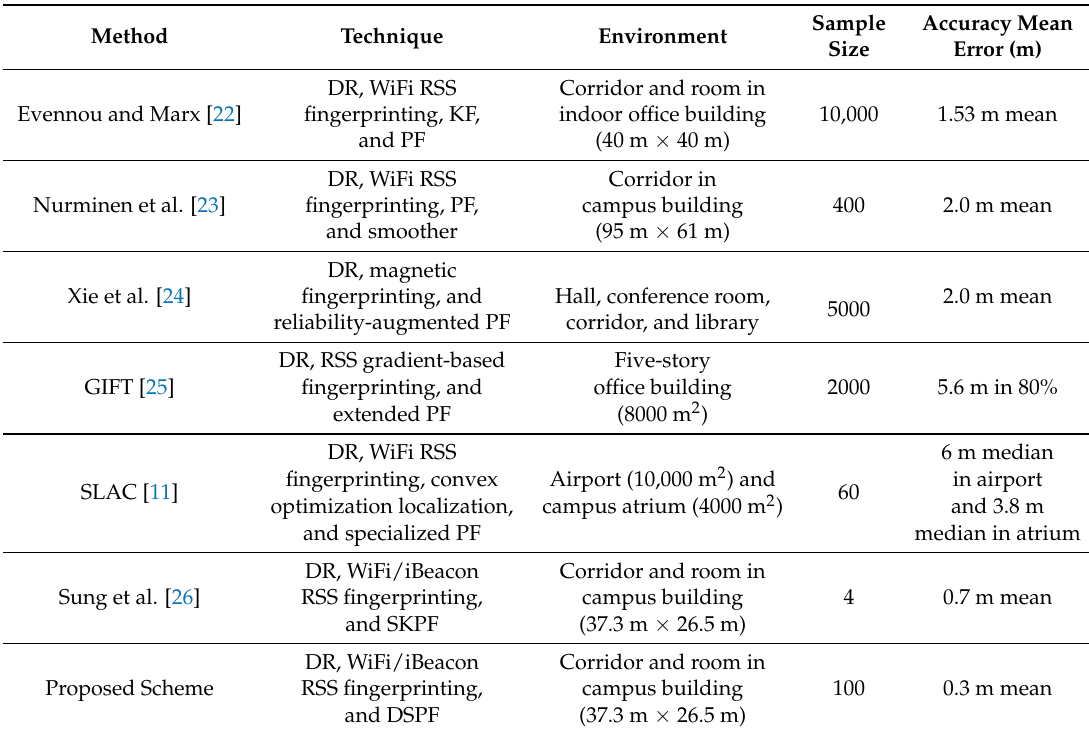
Table 1. Summary of indoor positioning approaches associated with the positioning algorithm suggested in this